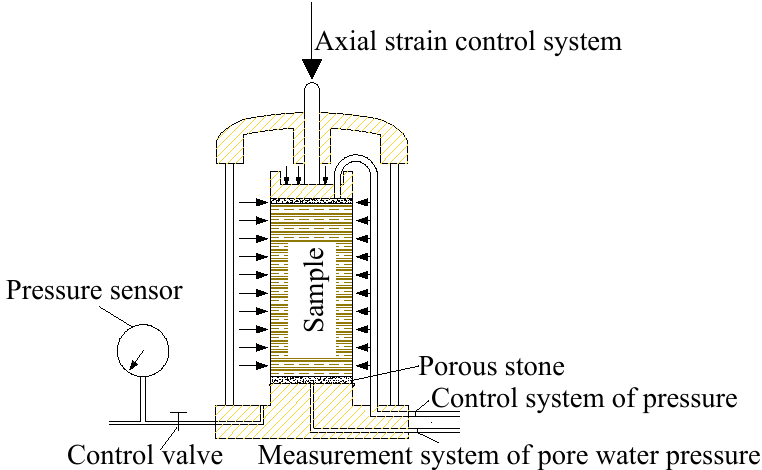
Figure 6. General scheme of the triaxial shear test system.